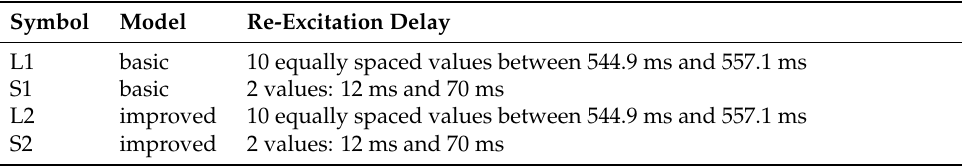
Table 3. Simulation parameters; positions are scaled to the length of the string, as in (2). Parameter Symbol Value sample rate 88,200 Hz excitation position 0.1899 initial displacement u 0 0.7 v 0 0.0 0.239 f